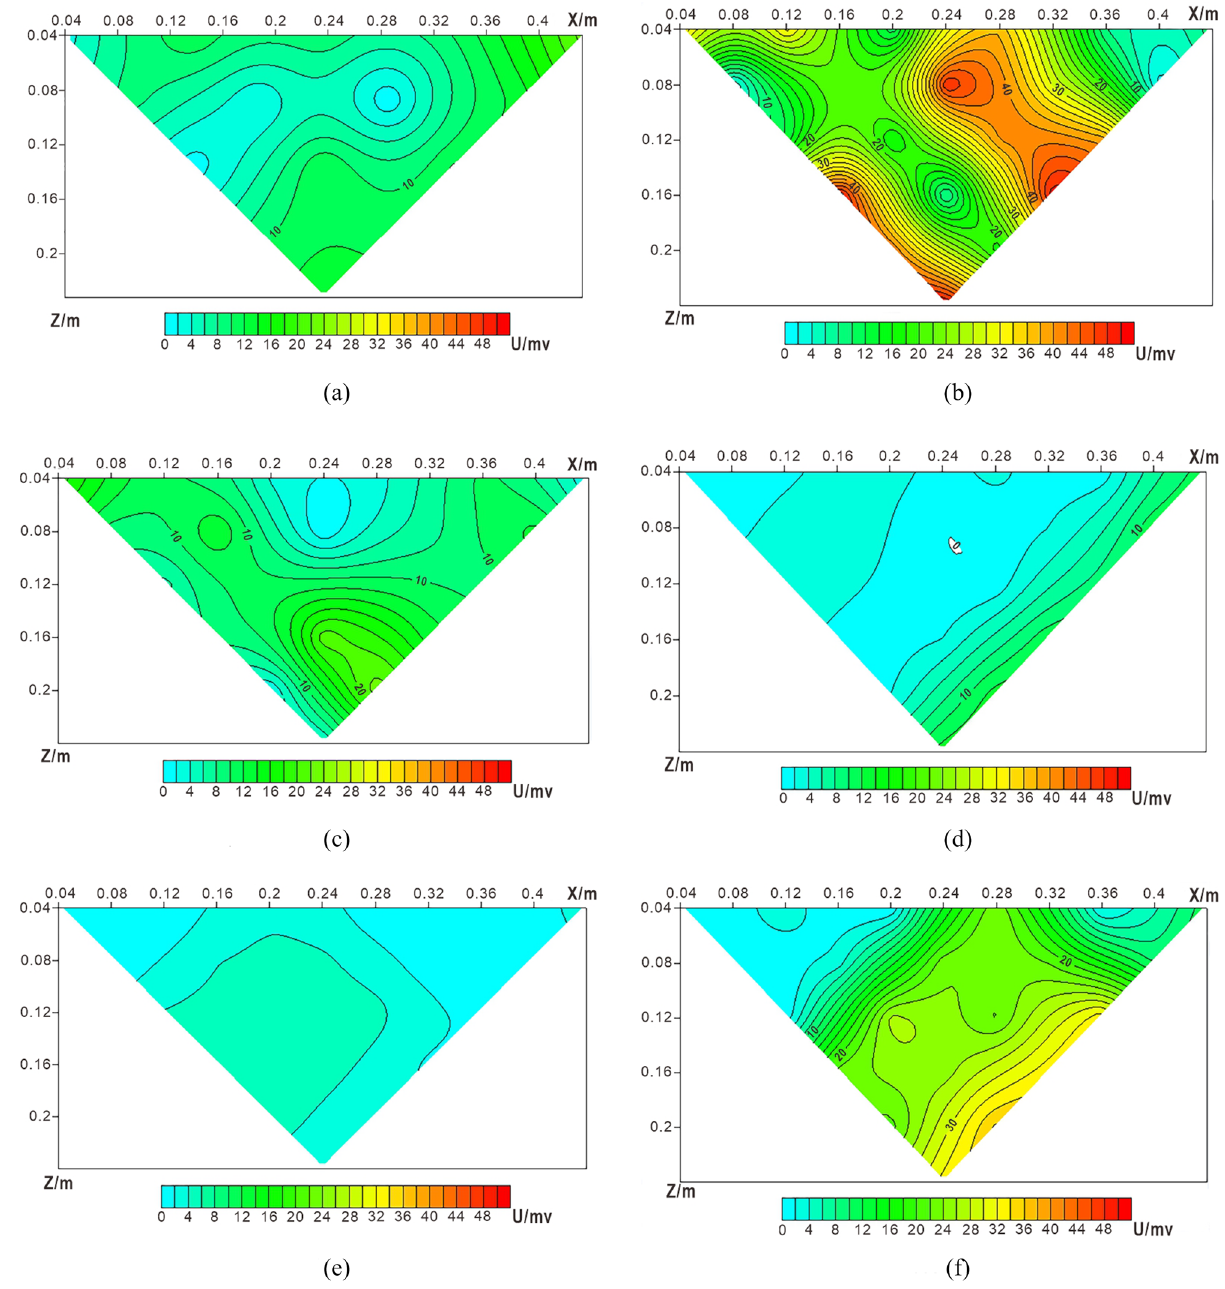
Figure 11. Electrical resistivity tomograms of profile: ( a ) Resistivity of the slitting profile Y = 0; ( b ) Resistivity of the slitting profile Y = 0.08; ( c ) Resistivity of the slitting profile Y = 0.16; ( d ) Resistivity of the slitting profile Y = 0.24; ( e ) Resistivity of the slitting profile Y = 0.32; ( f ) Resistivity of the slitting profile Y =